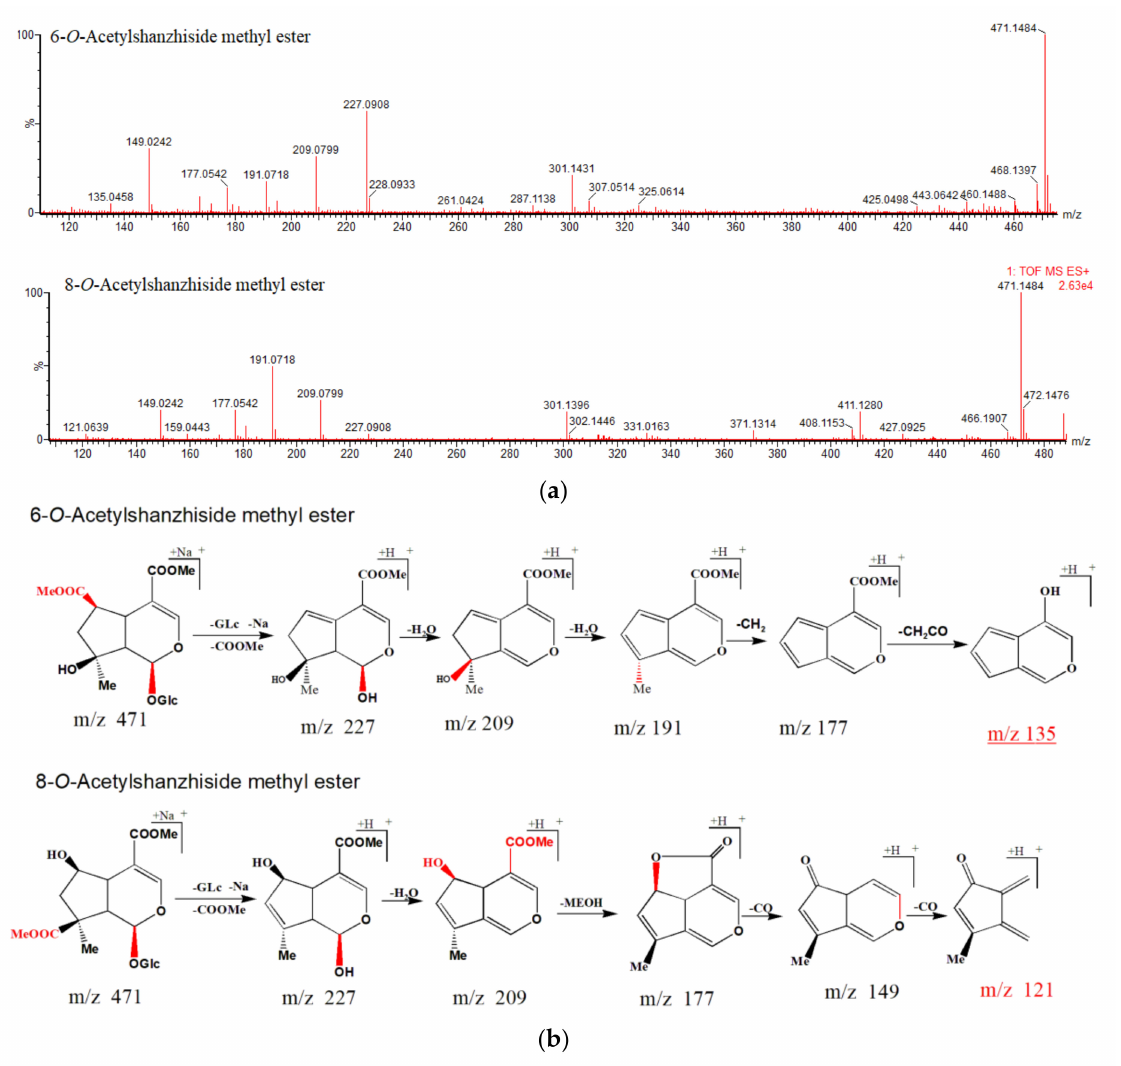
Figure 3. ( a ). MS 2 spectra of 8- O -acetylshanzhiside methyl ester and 6- O -acetylshanzhiside methyl ester. ( b ) Possible mass fragmentation pathways of 8- O -acetylshanzhiside methyl ester and 6- O -acetylshanzhiside methyl